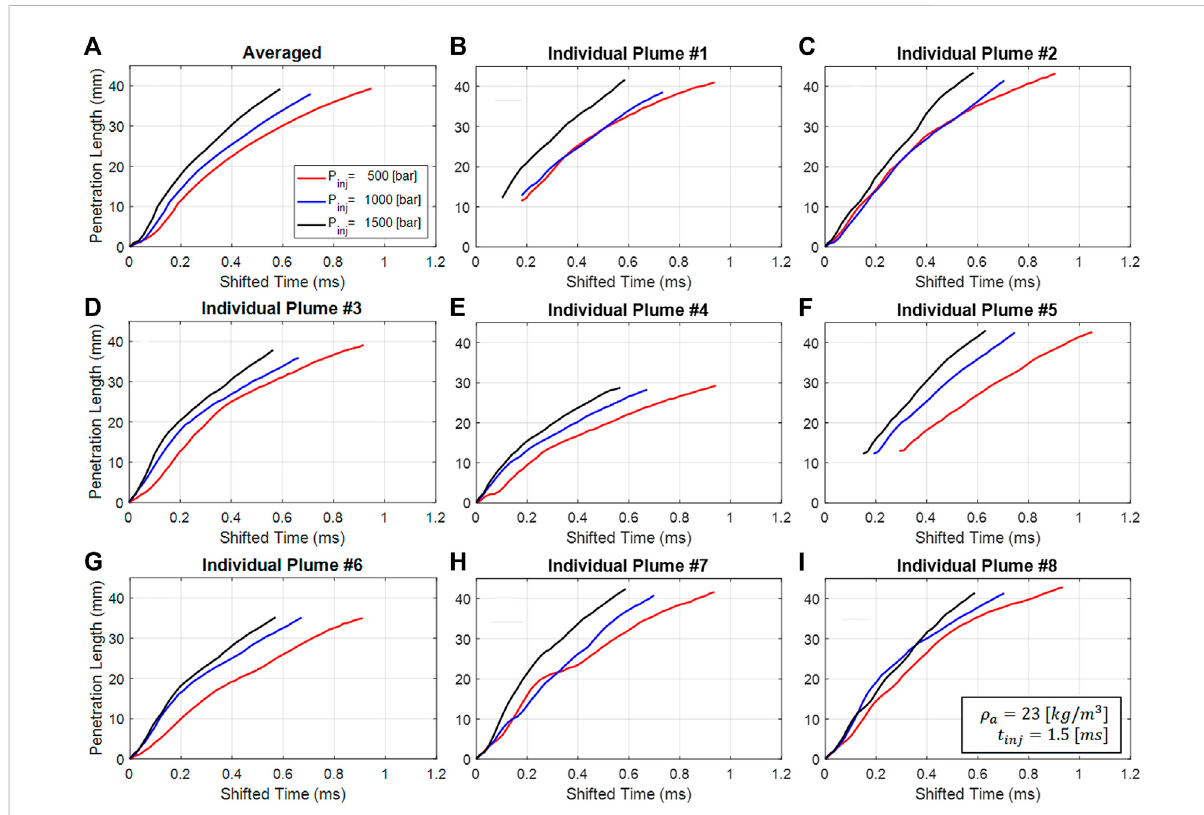
FIGURE 6 Spraypenetrationlengthofthemulti-holeinjectorwithdifferentde fi nitionsofplumesofinterest: (A) averagedplumebehavior(solidline), (B – I) Plumes #1 – 8, at an ambient density of 23 kg/m 3 and injection duration of 1.5